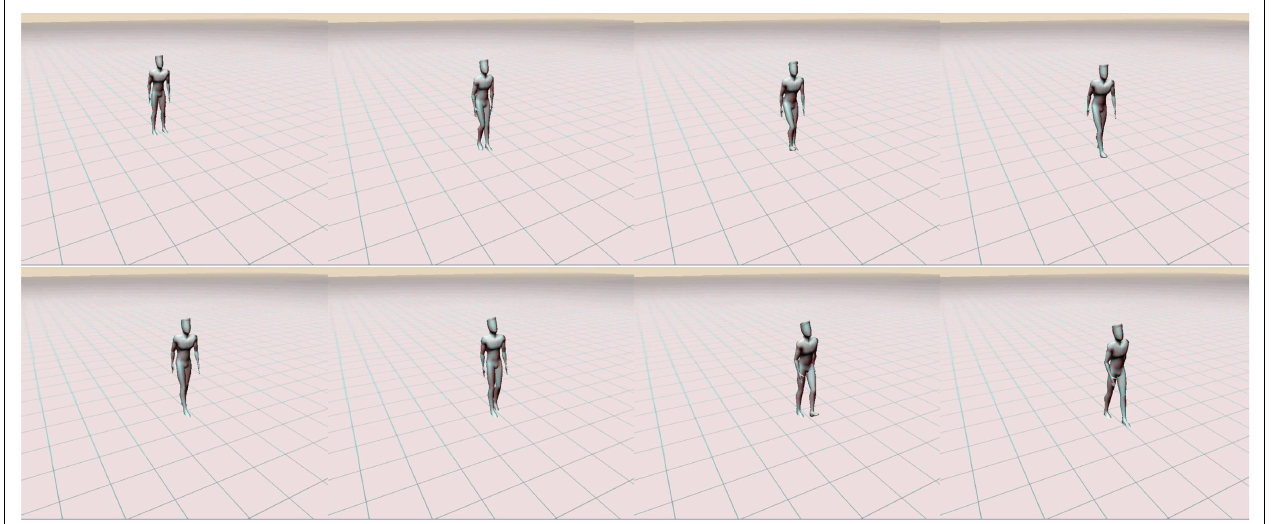
FIGURE 13 | Screenshots of the generated full-body walking motion as a result of the proposed approach